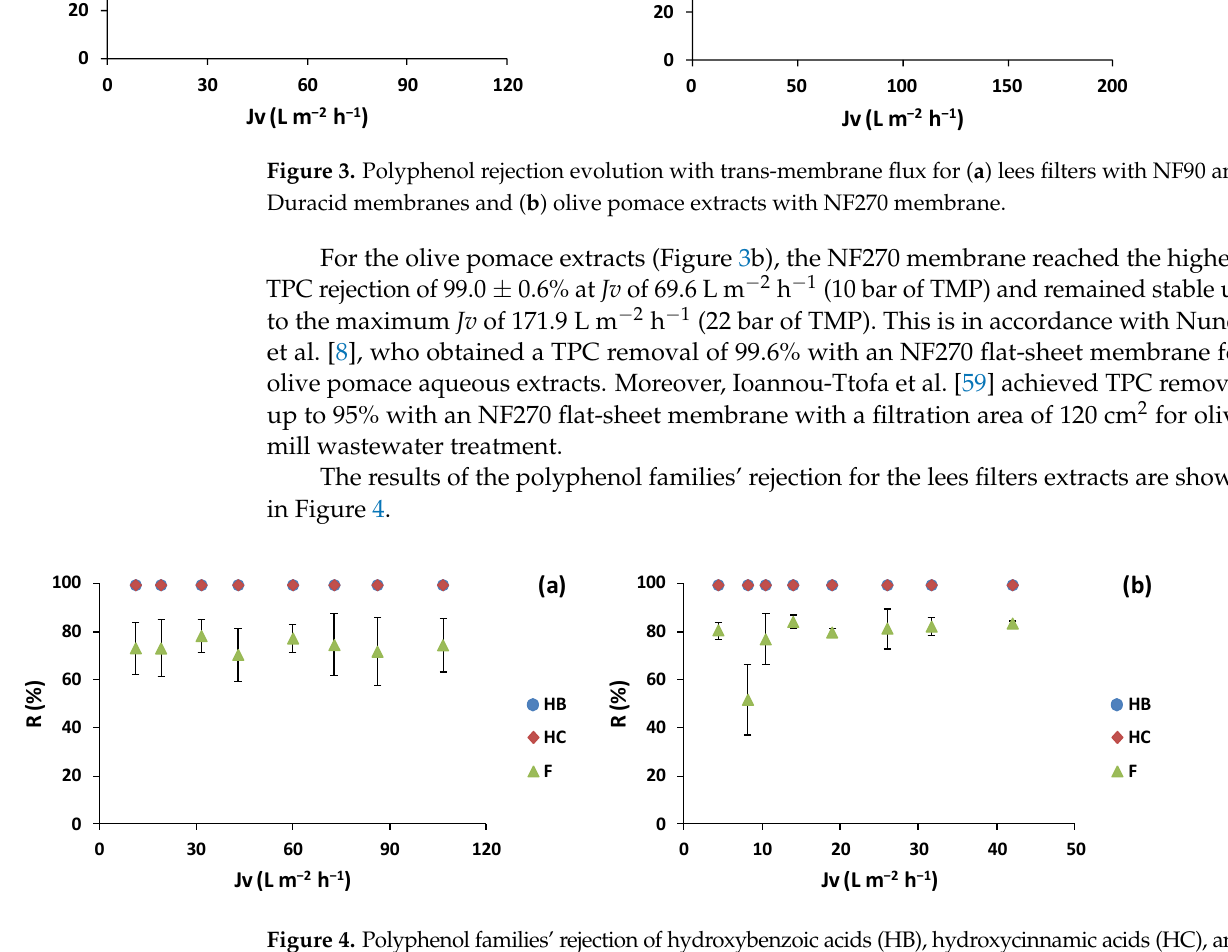
Figure 4. Polyphenol families’ rejection of hydroxybenzoic acids (HB), hydroxycinnamic acids (HC), and flavonoids (F) with trans-membrane flux for lees filters extracts with ( a ) NF90 and ( b ) Duracid membranes. The results indicated a similar behavior for the NF90 and Duracid membranes. Both membranes obtained concentrations of HB and HC families in the permeate streams below the HPLC-UV limit of quantification (LOQ < 0.5 mg L − 1 ). Regarding the flavonoid family, the NF90 membrane obtained a maximum F rejection of 78.5 ± 6.9% at a trans-membrane flux of 31.5 L m − 2 h − 1 (7 bar) and an average rejection of 74.1 ± 2.6%. On the other hand, the Duracid membrane obtained a maximum F rejection of 84.2 ± 2.8% at Jv of 14.0 L m −2 h −1 (10 bar) and an average rejection of 81.2 ± 2.5%. In the literature, Cassano et